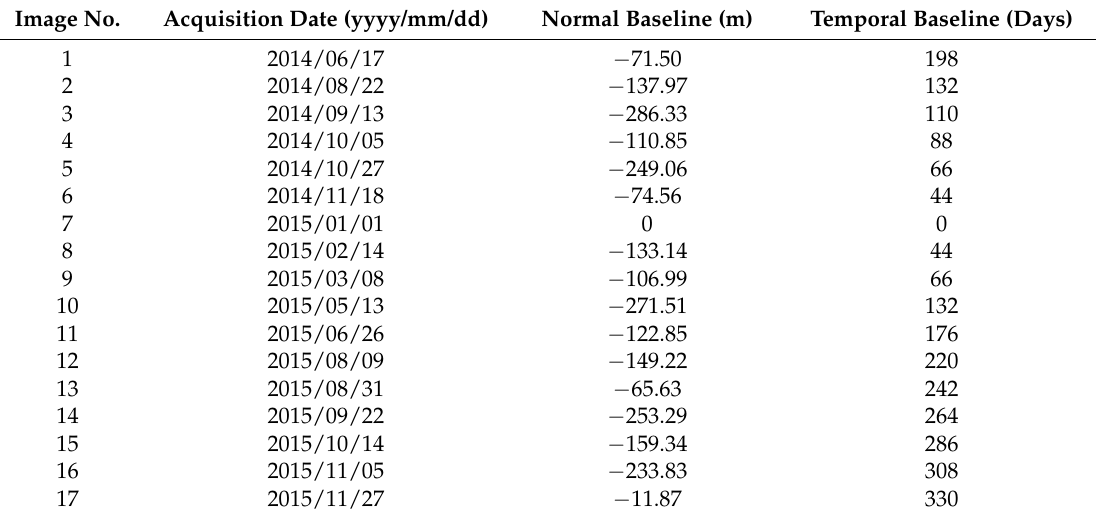
Table 1. List of the interferometric pairs and their parameters with image number 7 as the master (Orbit No.